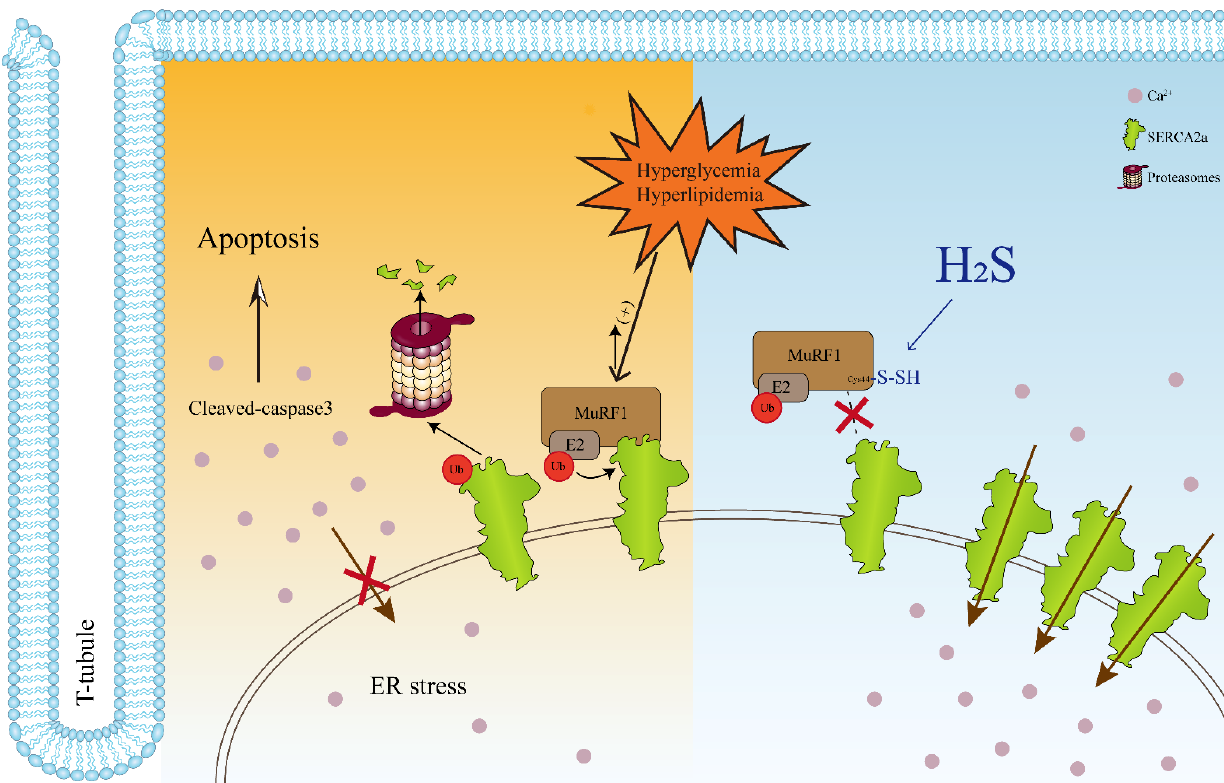
Figure 8. Model for the role of H 2 S in modifying MuRF1 S-sulfhydration to regulate SERCA2a ubiquitylation. In type 2 diabetic hearts, the endoplasmic reticulum protein SERCA2a protein is ubiquitinated by MuRF1, an E3 ubiquitin ligase, for proteasomal degradation. The increase of cytoplasmic calcium ion concentration leads to the decrease of myocardial contractile function, the decrease of endoplasmic reticulum calcium ion causes ER stress, and the excessive ER stress induces cell apoptosis. Meanwhile, H 2 S mediates S-sulfhydration at the Cys44 site of MuRF1, which reduces the ubiquitination level of SERCA2a, protects myocardial contractile function, and reduces the level of